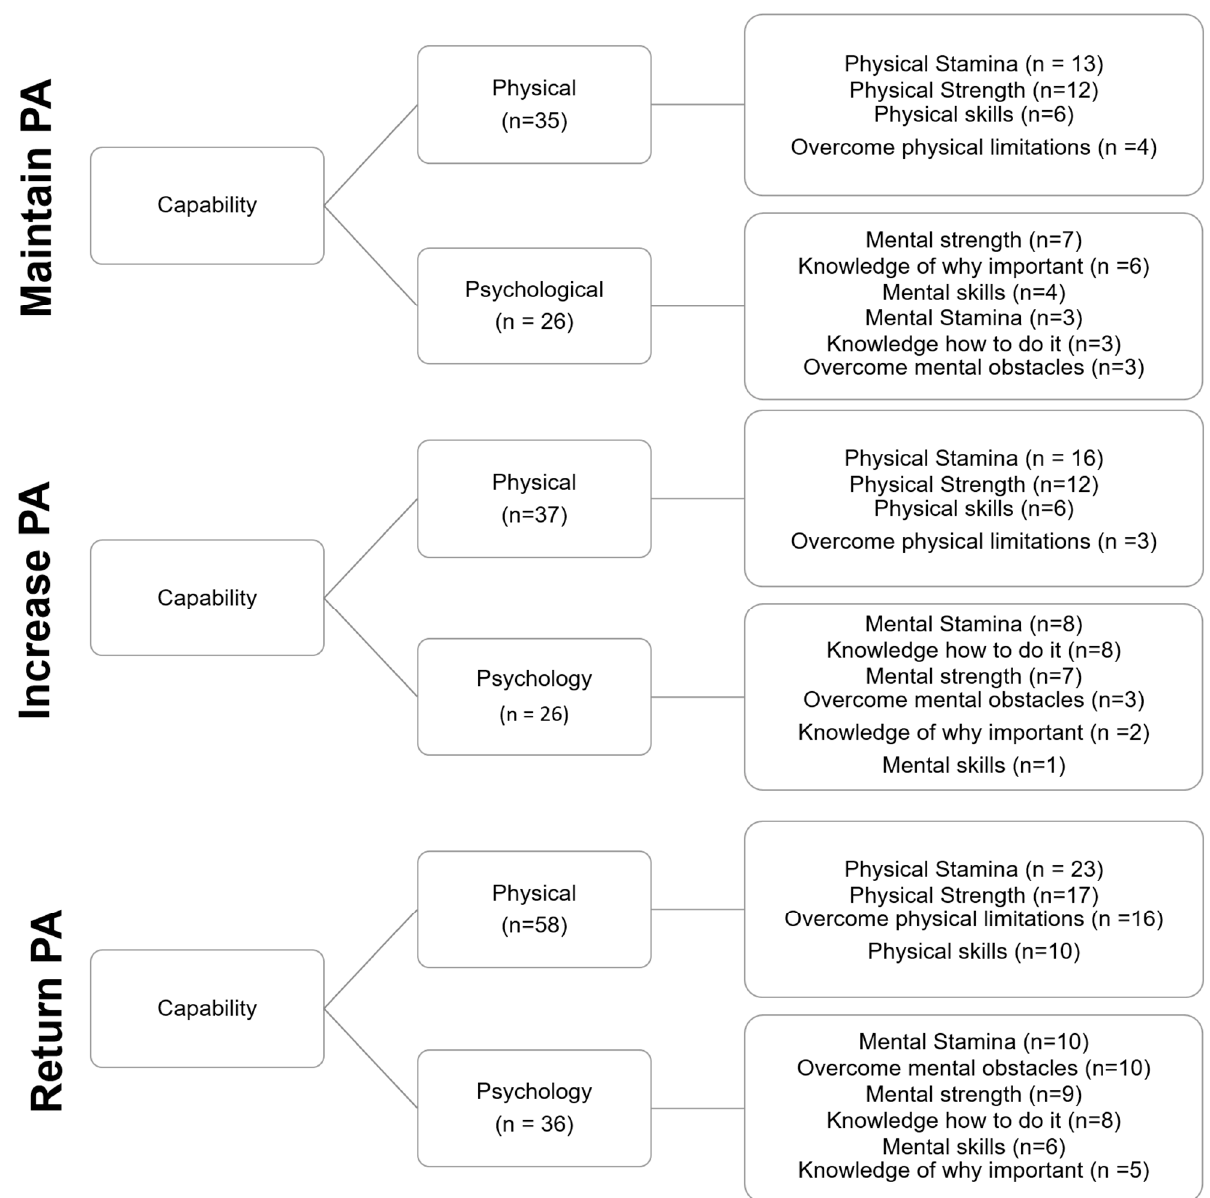
Figure 4. Perceived capability barriers grouped by intended PA target behaviour.